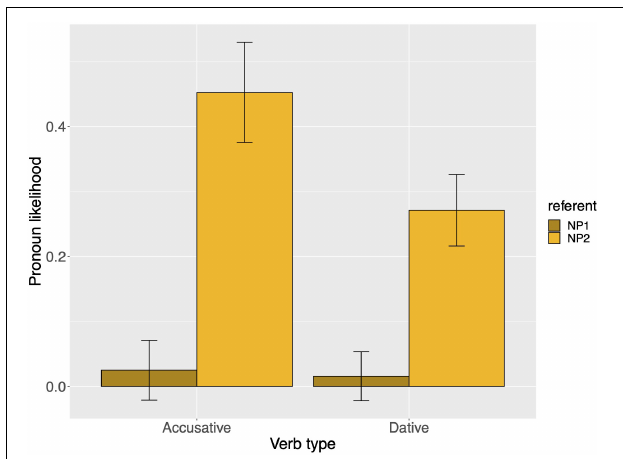
FIGURE 3 | Demonstrative pronoun: probability of using a demonstrative pronoun to refer to NP1 and NP2, per verb type, for Experiment 1. These bars represent the pronoun production likelihoods (and are therefore based on the free-prompt data). Error bars are by-participant and represent 95% confidence intervals based on normalized data following Morey (2008) and Chang